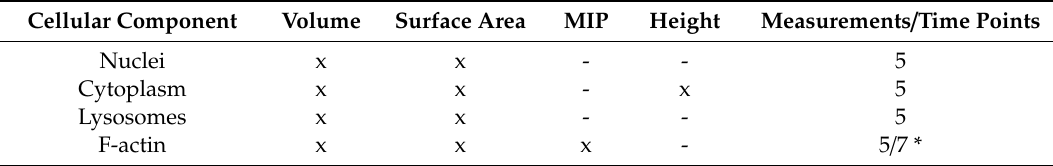
Table 4. Overview of analyzed parameters and number of measurements / time points of the investigated cellular components.